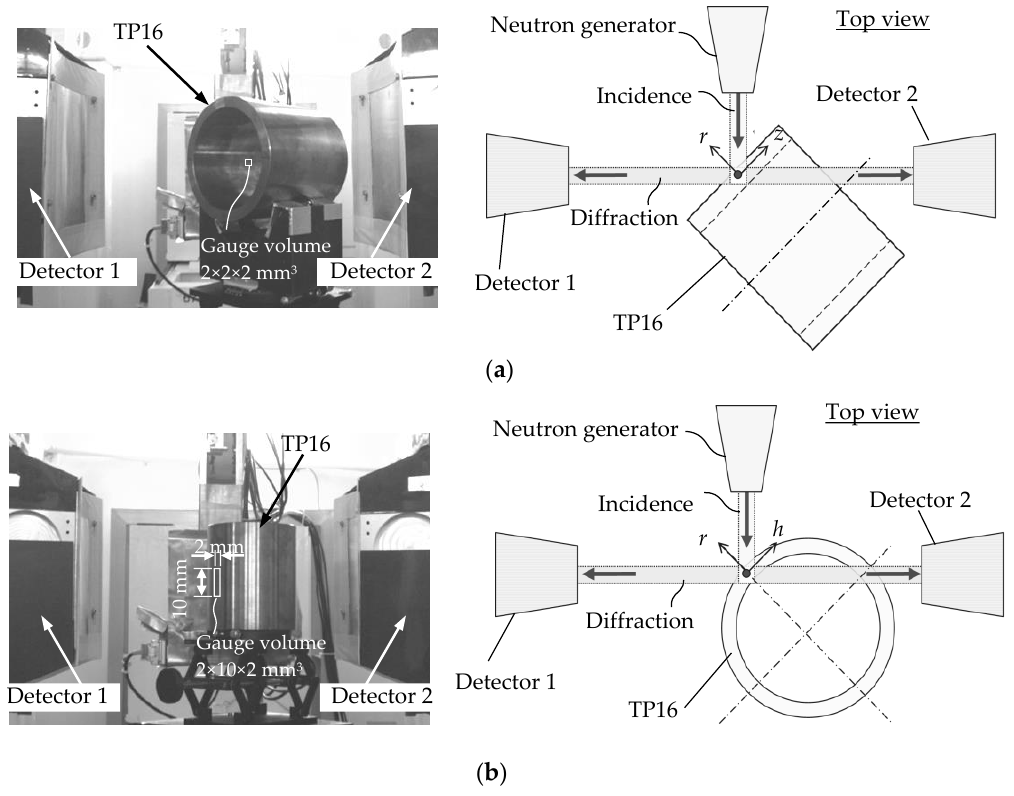
Figure 5. Setup image and optical system of neutron diffraction measurement of hollow cylinder specimen. ( a ) Measurement in radial ( r ) and axial ( z ) directions, ( b ) Measurement in radial ( r ) and hoop ( h ) directions [13].